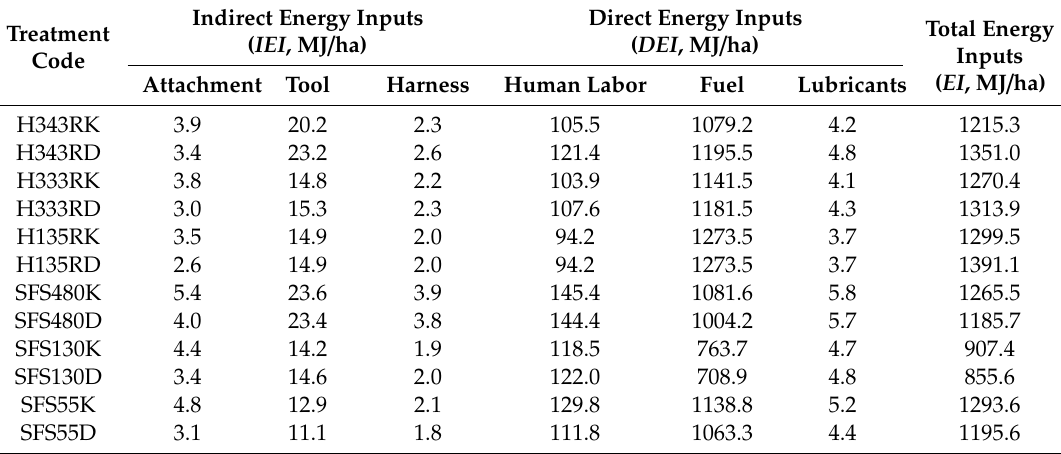
Table 4. Breakdown of energy inputs on categories and